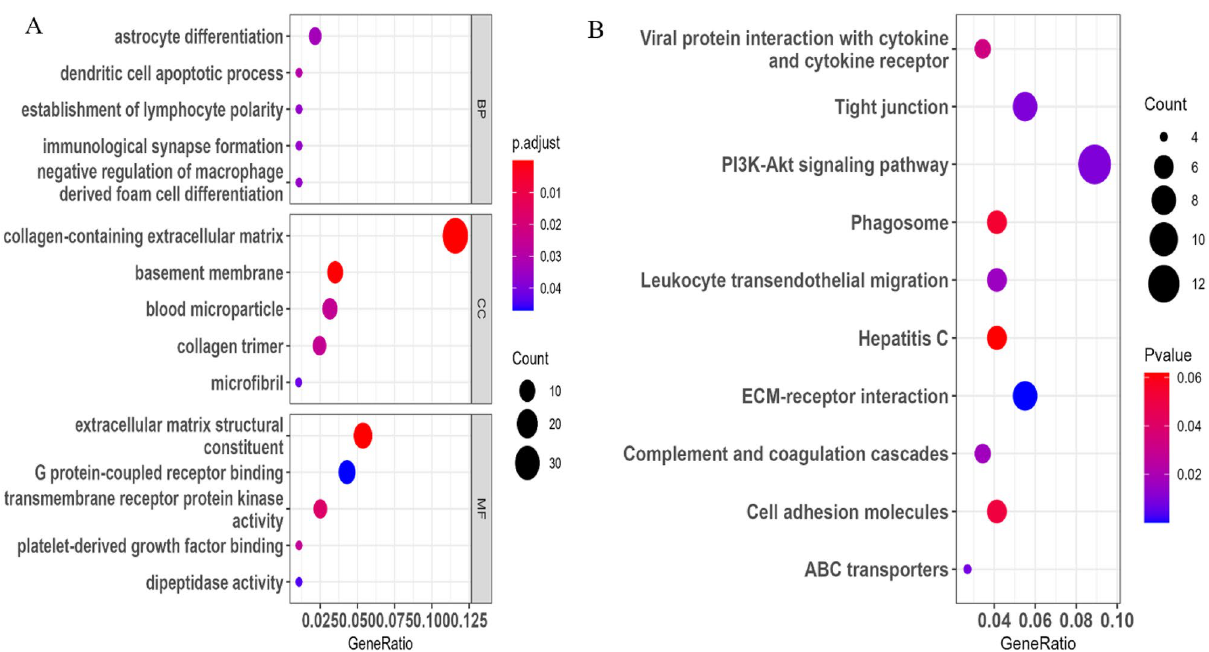
Figure 2. Enrichment analysis of cirrhosis-related DEGs. GO analysis ( A ) and KEGG pathway enrichment analysis ( B ). GO: Gene Ontology; KEGG: Kyoto Encyclopedia of Genes and Genomes; DEGs: differentially expressed